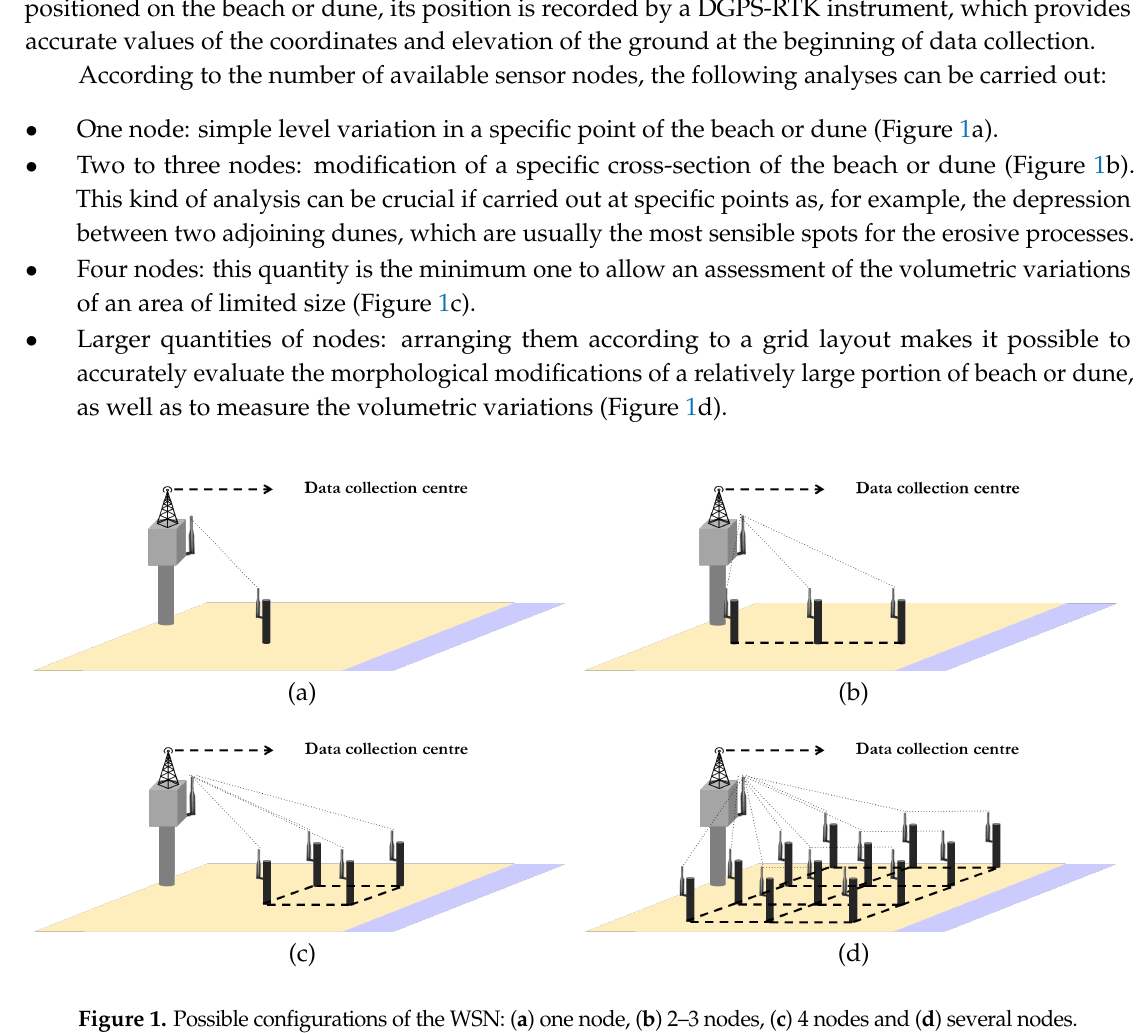
Figure 1. Possible configurations of the WSN: ( a ) one node, ( b ) 2–3 nodes, ( c ) 4 nodes and ( d ) several